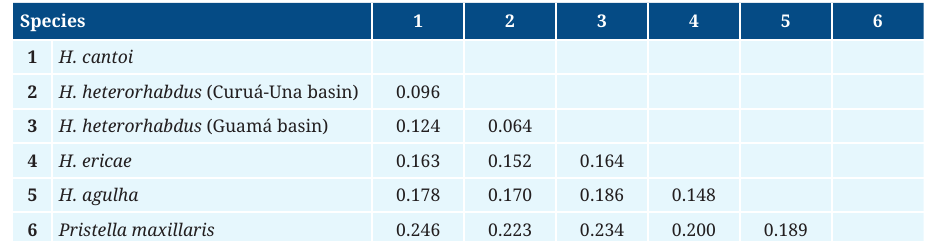
TABLE 2 | Pairwise genetic distances (K80 model) between Hyphessobrycon species and Pristella maxillaris